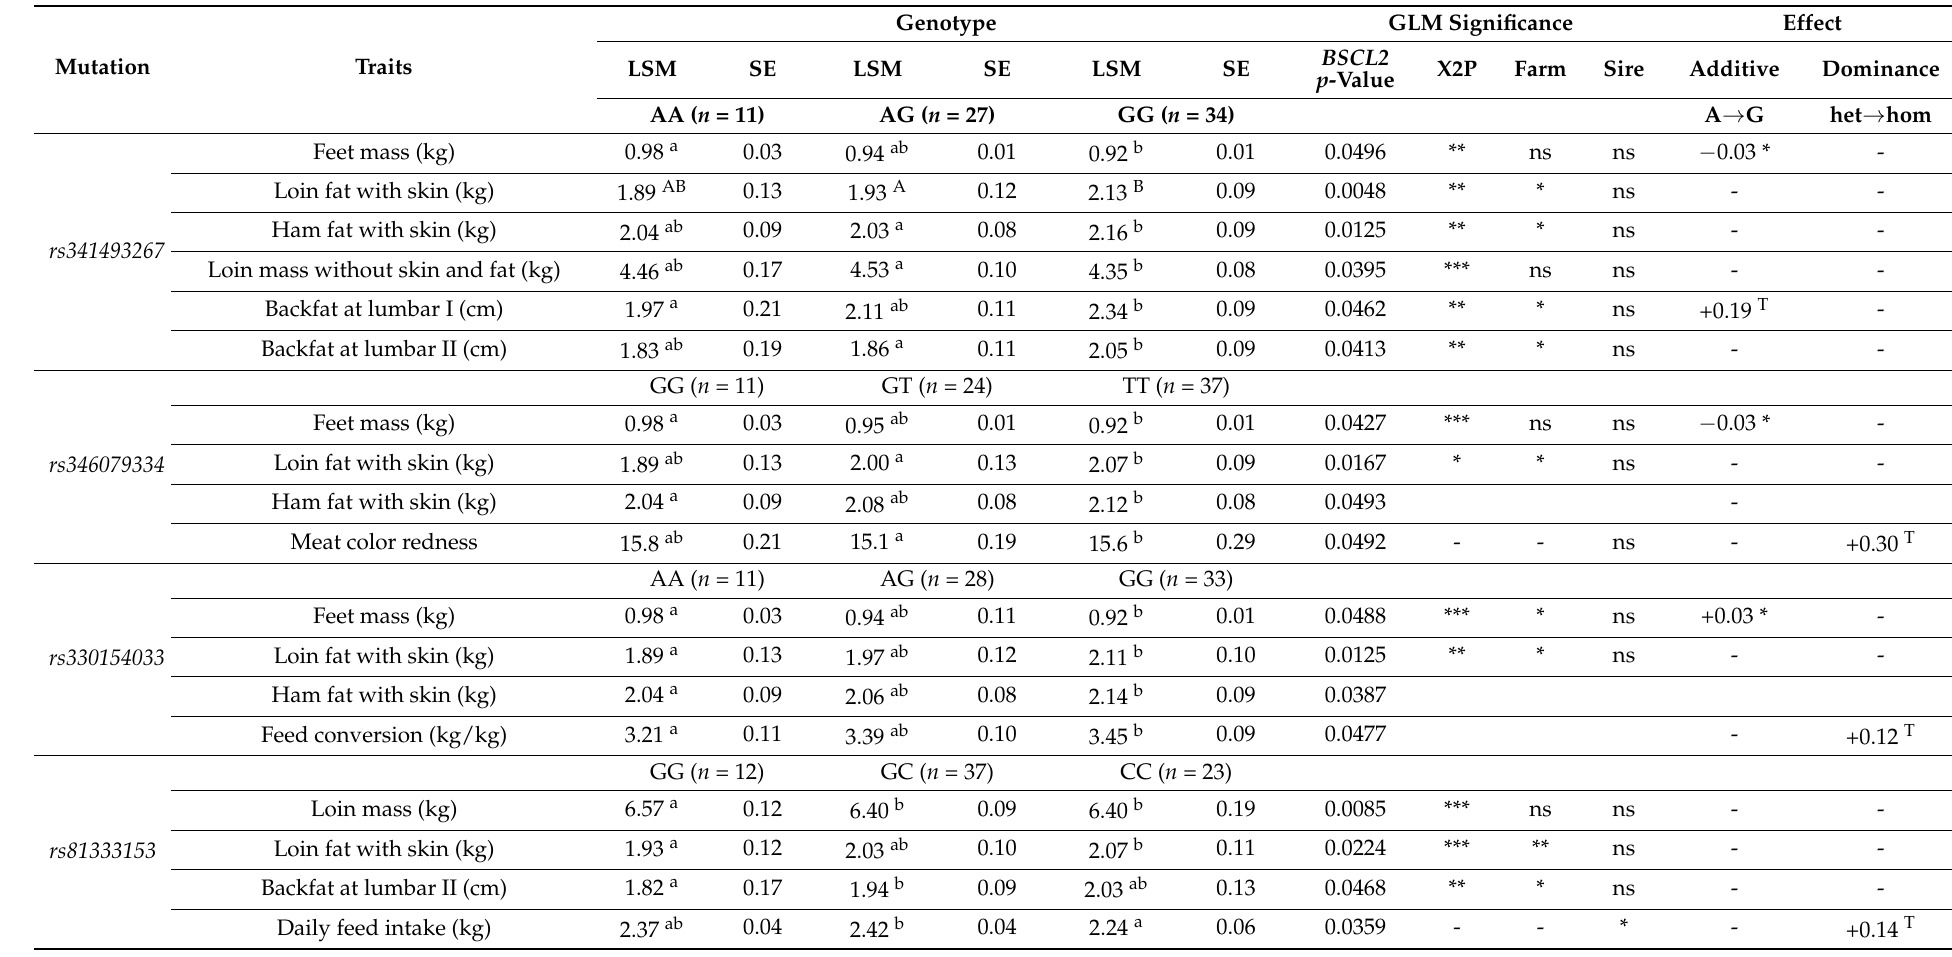
Table 5. Means as least-square means (LSM) with standard error (SE) for pig production traits dependent on BSCL2 genotypes for Złotnicka White.